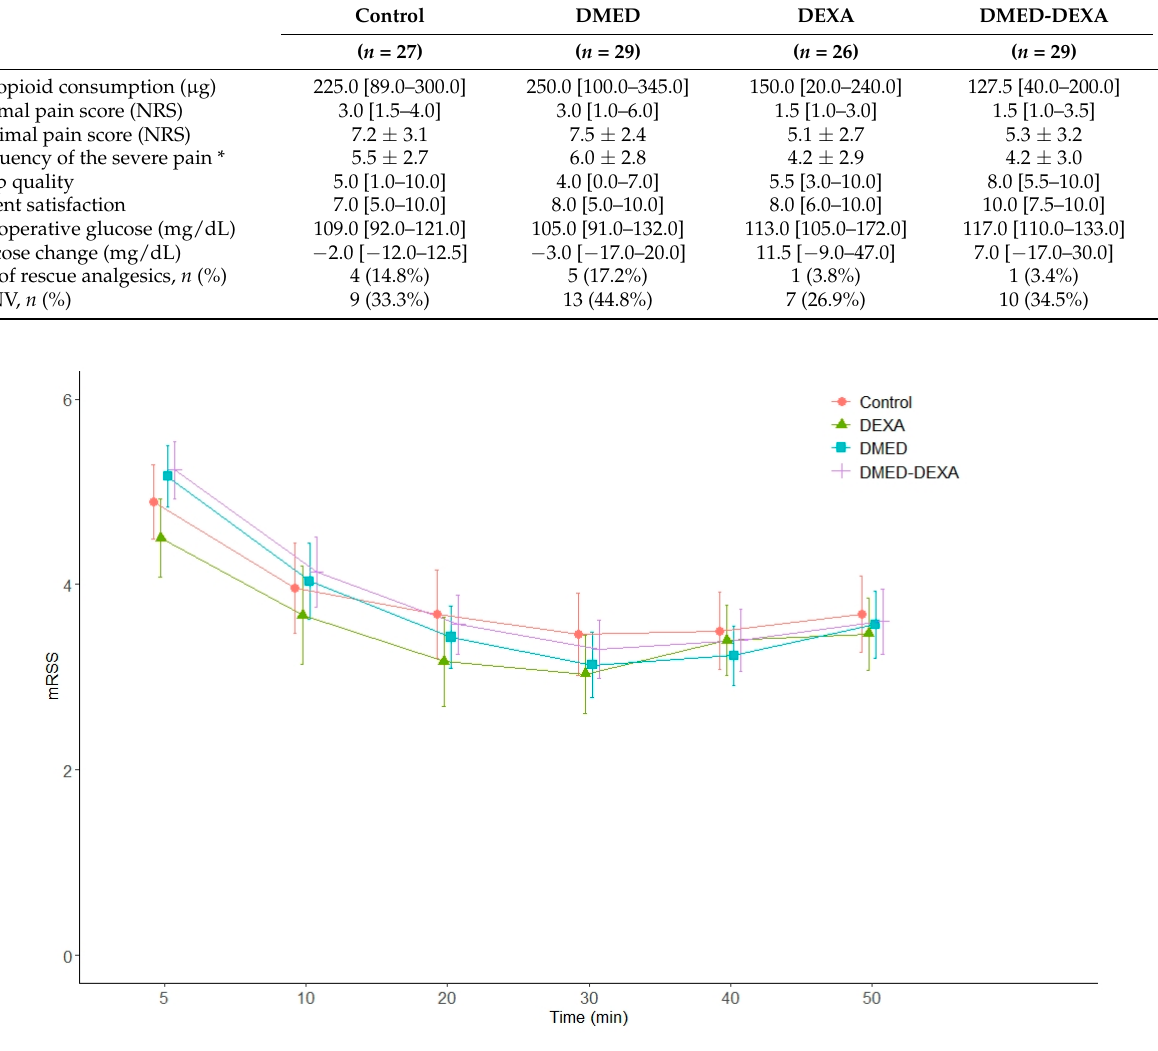
Figure 4. Changes in depth of sedation during and after surgery in the four study groups. mRSS (modified Ramsay Sedation Scale) 5 and 10 min after the start of sedation and every 10 min thereafter, up to 50 min.